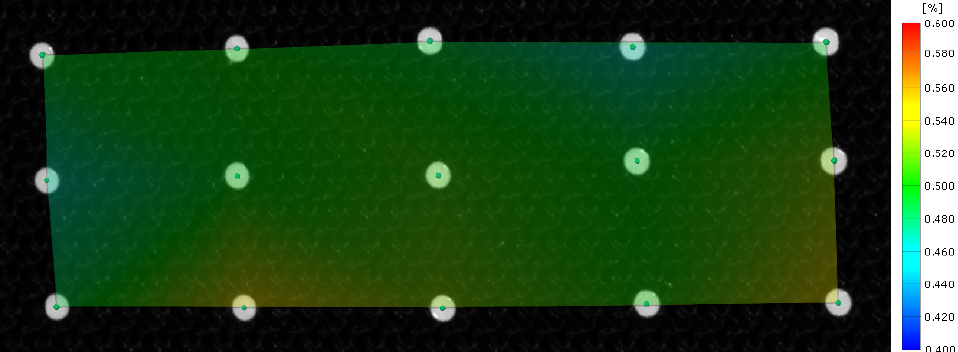
Figure 7. Digital image correlation (DIC) generated transverse-strain field (overlaying the capture